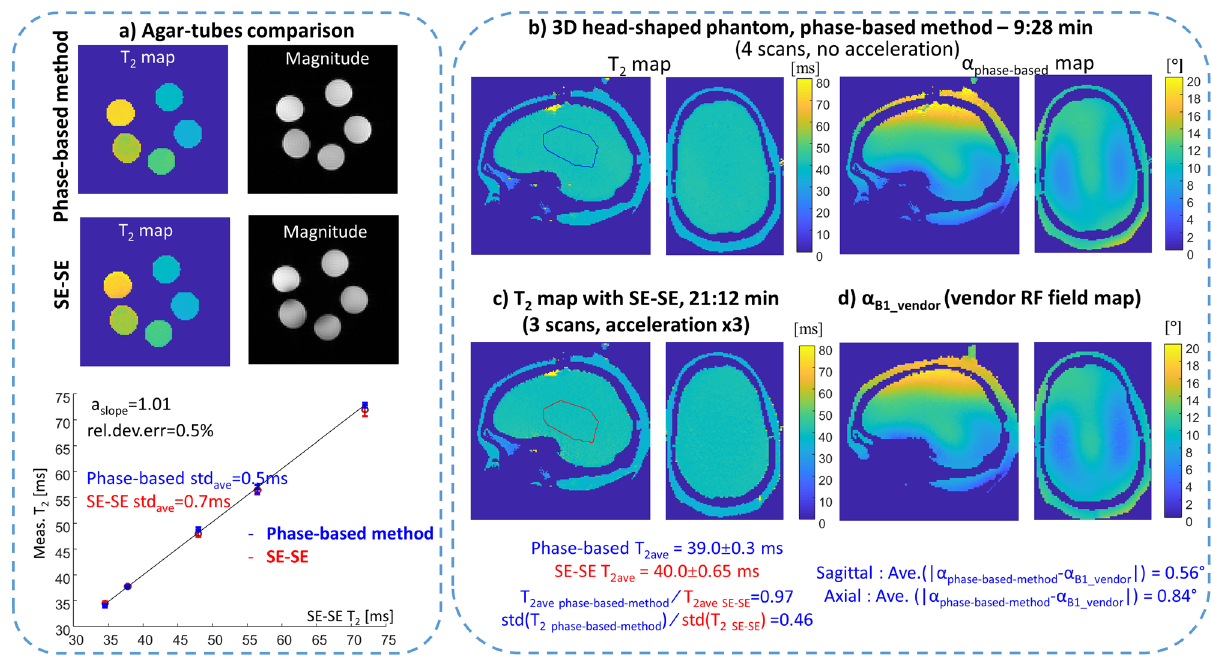
Figure 3. Assessment of estimation bias and variability in phantoms. ( a ) Comparison of the T 2 obtained with the phase-based method and SE–SE in agar tubes. Top—a central slice of the T 2 maps and magnitude images. Bottom—estimated T 2 for each tube as a function of T 2 with SE–SE; a slope = 1.01, relative deviation error = 0.5%. The average standard deviation was 0.5 ms for the phase-based method, and 0.7 ms for SE–SE. ( b – d ) Comparisons using a 3D-head-shaped brain-like phantom. ( b ) T 2 and α maps estimated by the phase-based method. ( c ) T 2 map estimated with SE–SE. And ( d ) α map estimated using the vendor’s RF field mapping scan. Two main cross-sections are shown for all cases, Sagittal and Axial. For comparison, the average T 2 and standard deviation was calculated in the same region of interest (marked by a blue contour for the phase-based method and a red contour for SE–SE). The average deviation between the α maps of the phase-based method and of the vendor’s RF mapping was calculated to be 0.56° for the Sagittal plane and 0.84° for the Axial